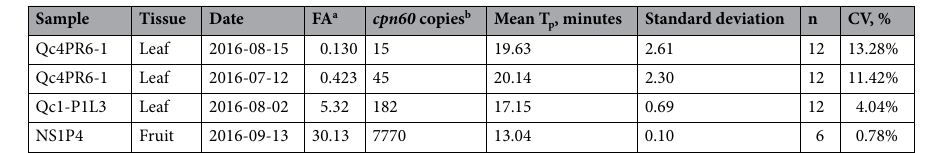
Table 2. LAMP assay repeatability. a Fractional abundance of BBSP phytoplasma as determined by ddPCR; see text. b cpn60 copies/assay, measured by ddPCR; see text.